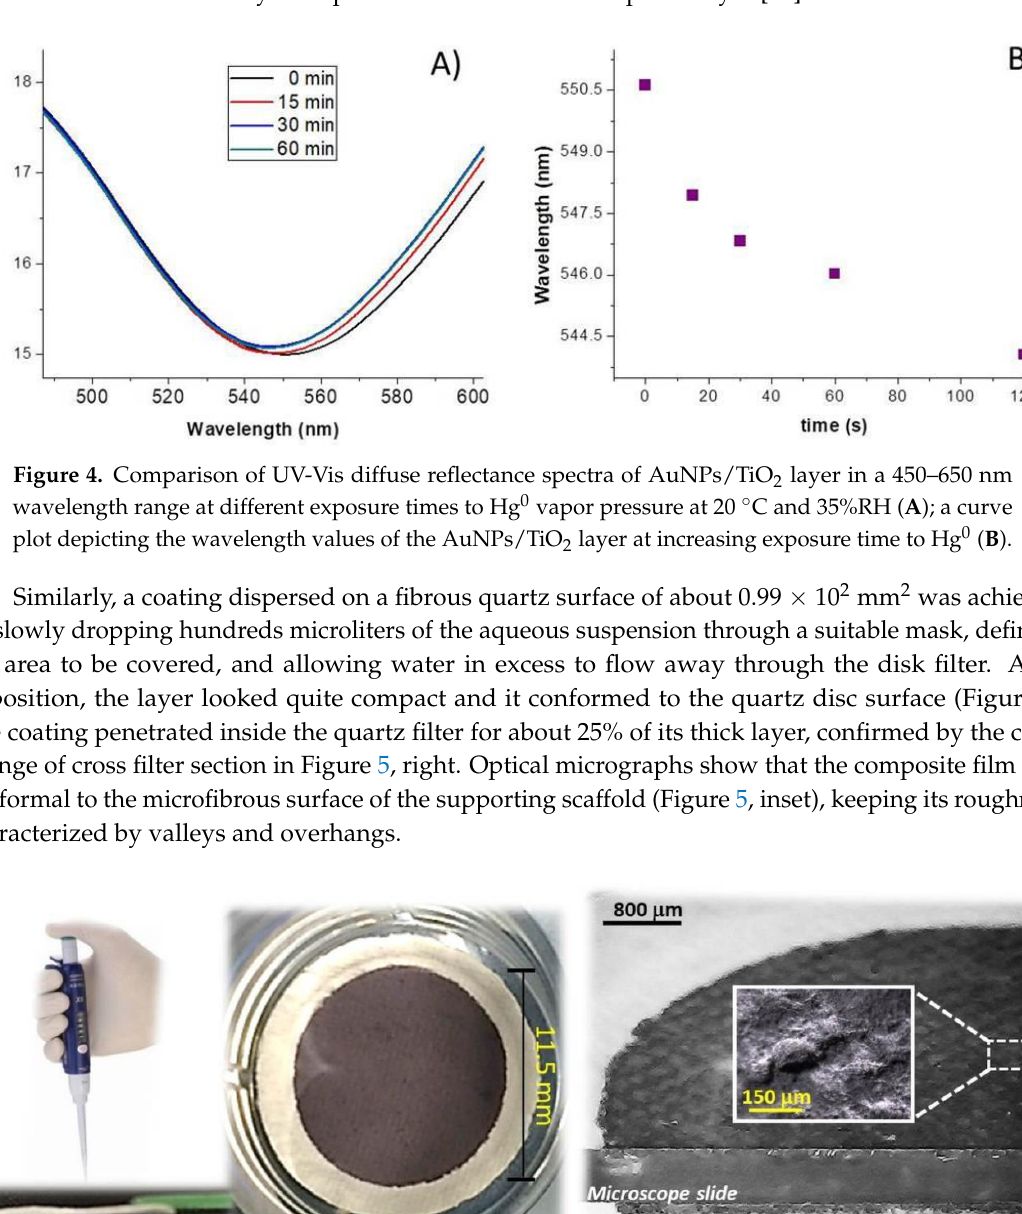
Figure 5. (Left) Drop deposition of TiO 2 /AuNPs aqueous suspension; top view (middle) and side view (right) of the resulting disc. The inset depicts an optical magnification of the film surface.